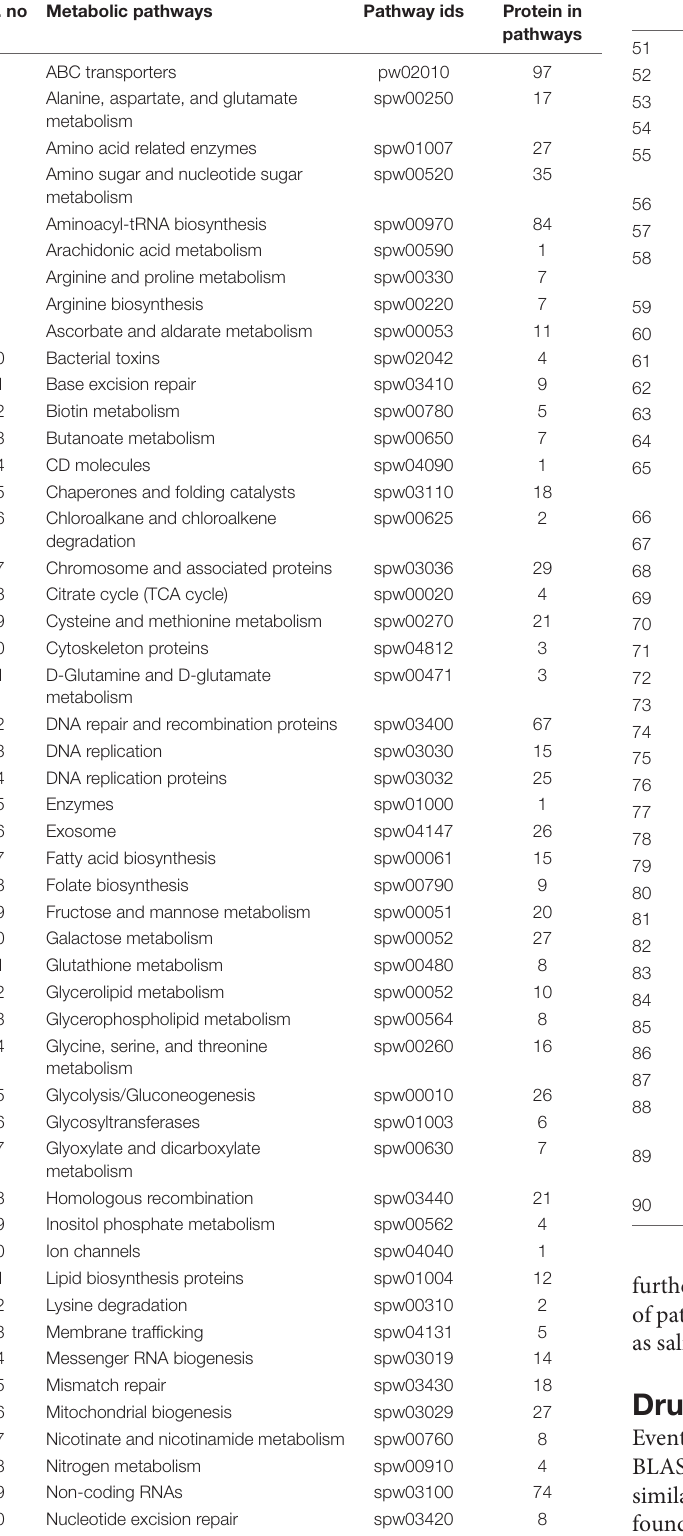
TABLE 3 | Common metabolic pathways: List of all common metabolic pathways, commonly shared by both organisms ( S. pneumoniae and Human). S. no Metabolic